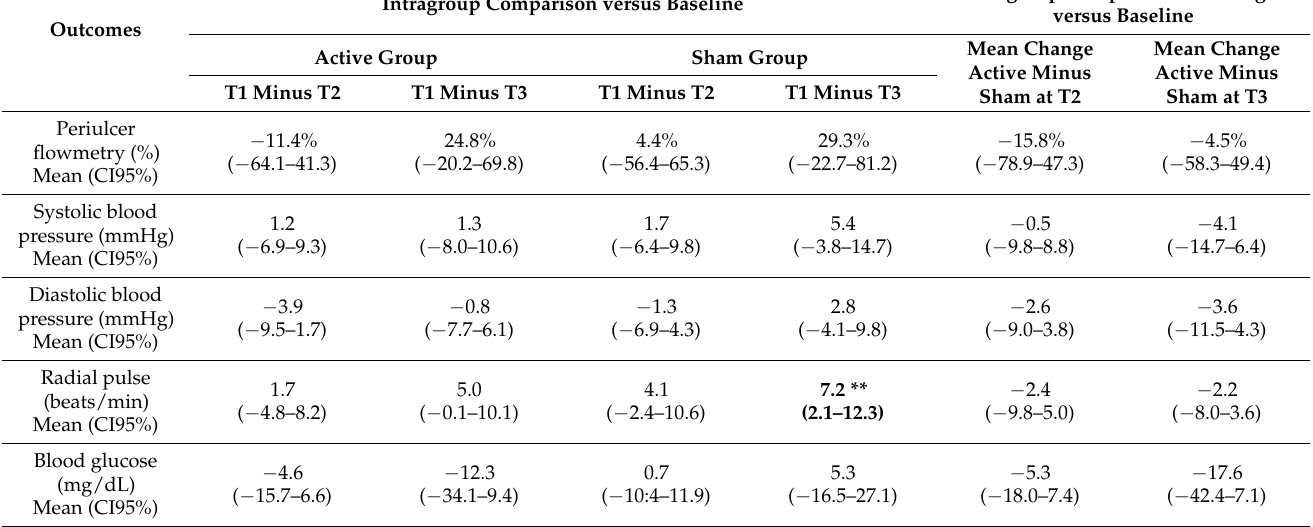
Table 3. Results of quantitative secondary variables: intra-group and intergroup comparisons versus baseline.